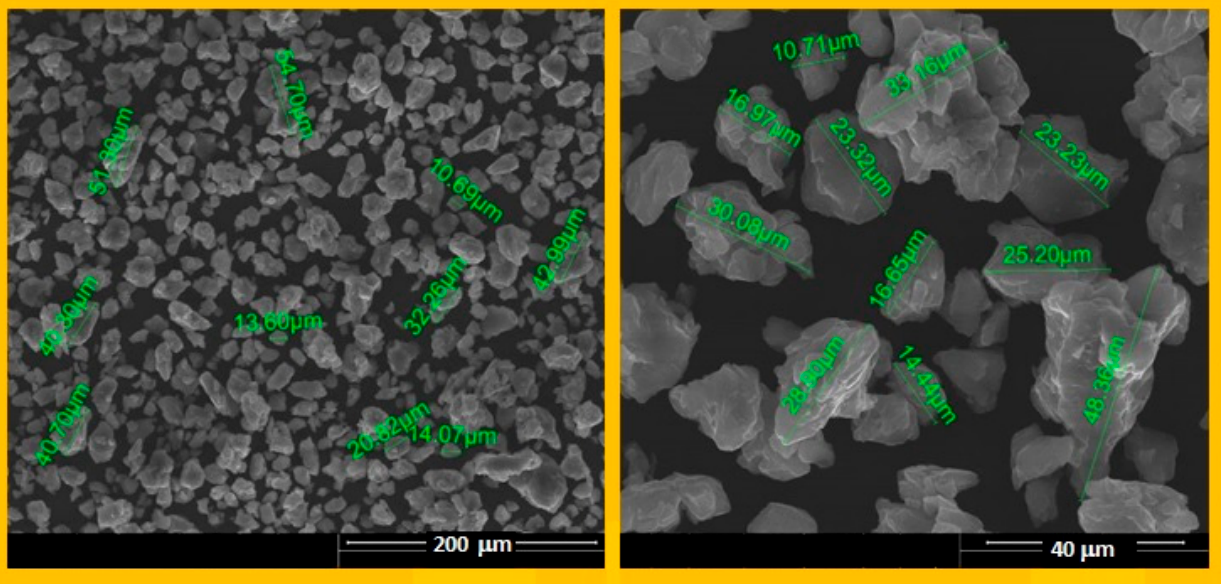
Figure 13. The SEM ‐ SE images for the Mg ‐ 10Zn ‐ 0.8Ca ‐ 0.5Zr alloy after MA with 300 rpm/28 h/10:1 Figure 13. The SEM-SE images for the Mg-10Zn-0.8Ca-0.5Zr alloy after MA with 300 rpm/28 h/10:1 applied parameters and final sieving < 30 μ m. applied parameters and final sieving < 30 µ